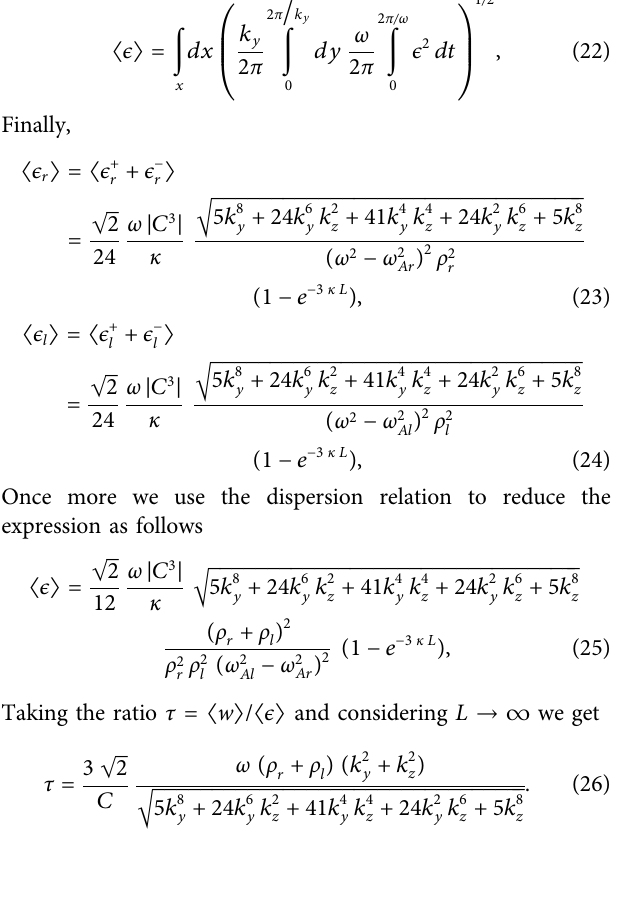
Van Doorsselaere et al. (2020a) generalized this method and used the root-mean-square approach while averaging over a period and the φ direction. In order to avoid an energy cascade equal to zero, we use the root-mean-square approximation while averaging over the y direction and period.